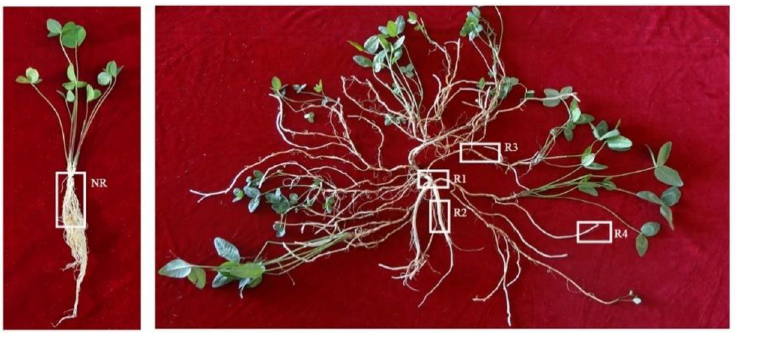
Fig 1. Schematic diagram of plant